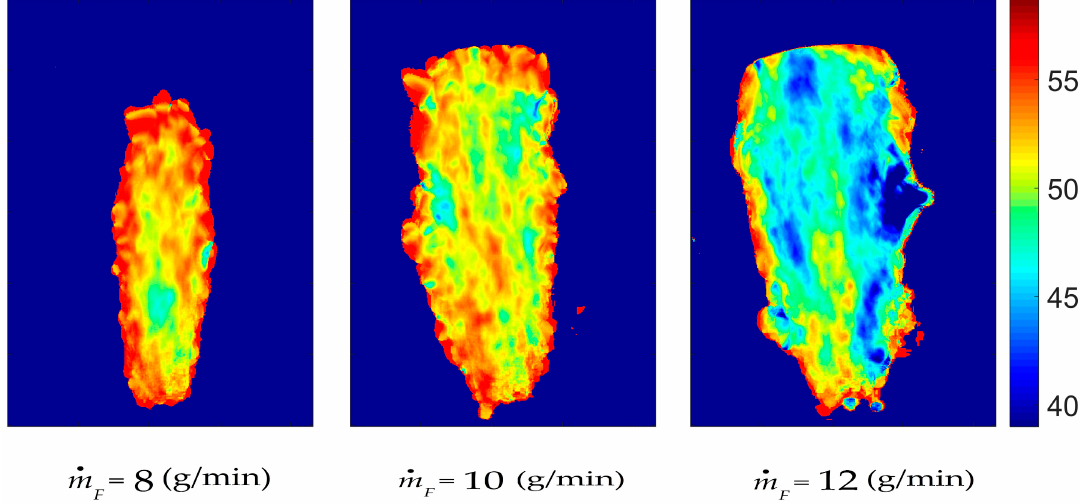
Figure 5. The distribution of flickering weighted average frequency for the mass flow rate of fuel.